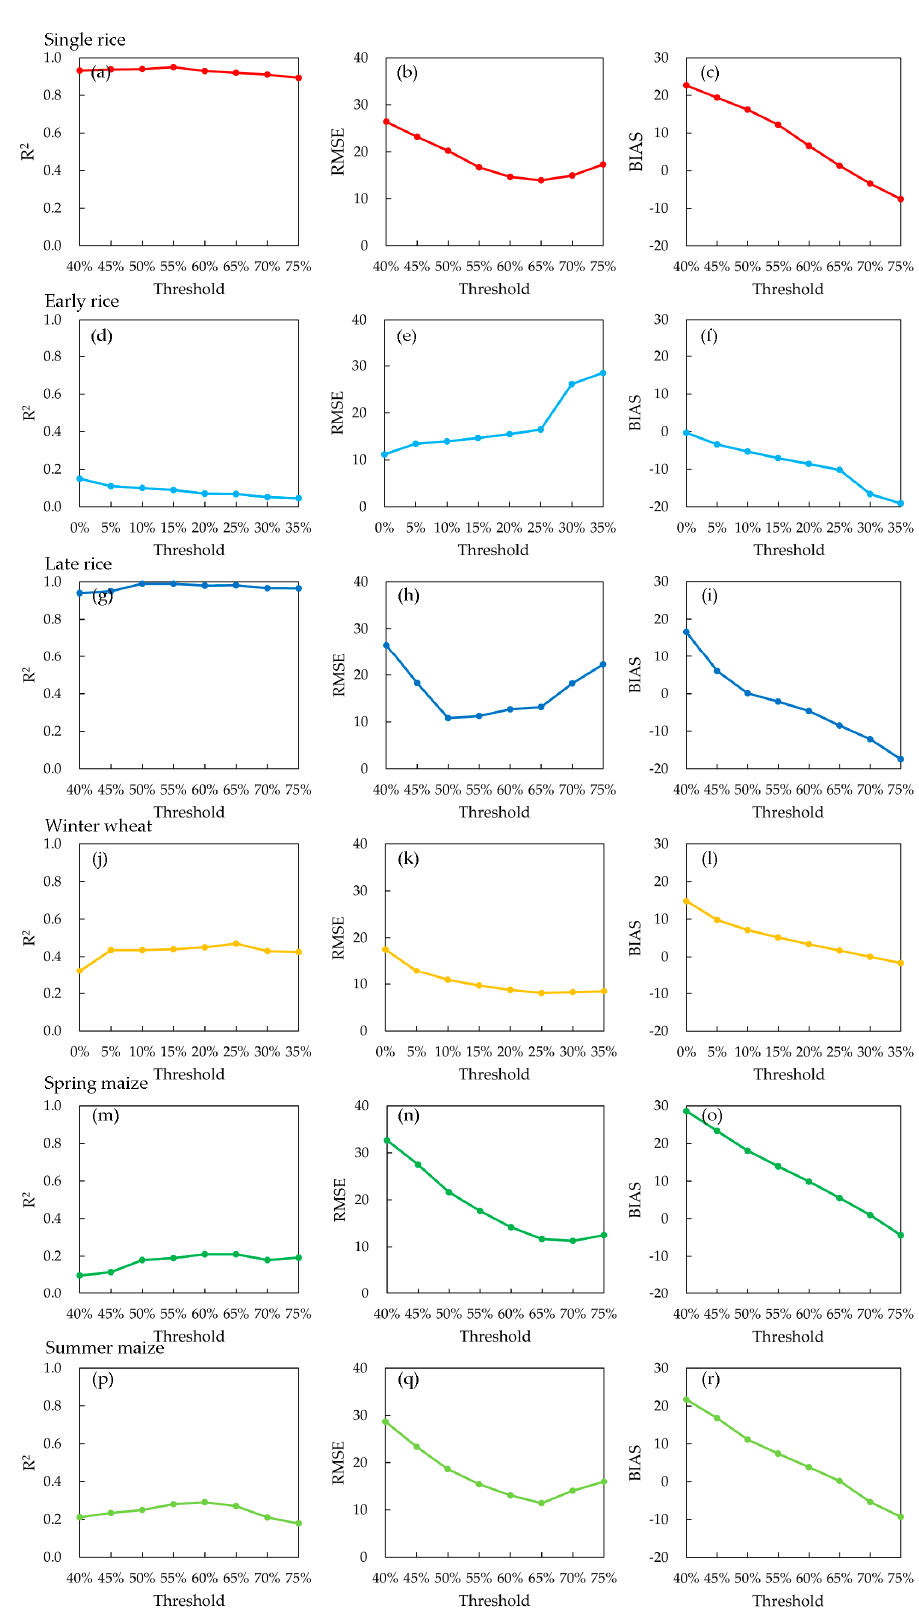
Figure 6. Crop-specific the end of the season (EOS) retrieval accuracies based on Normalized Difference Vegetation Index (NDVI) under different thresholds.